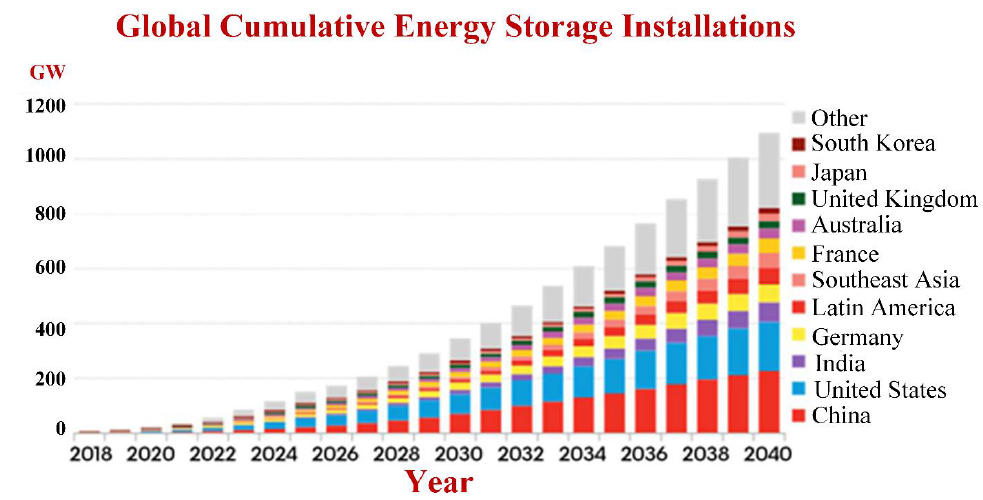
Figure 84. The global cumulative energy storage forecast for 2040 according to the Energy Storage Outlook 2019 by Bloomberg NEF (BNEF) [342].